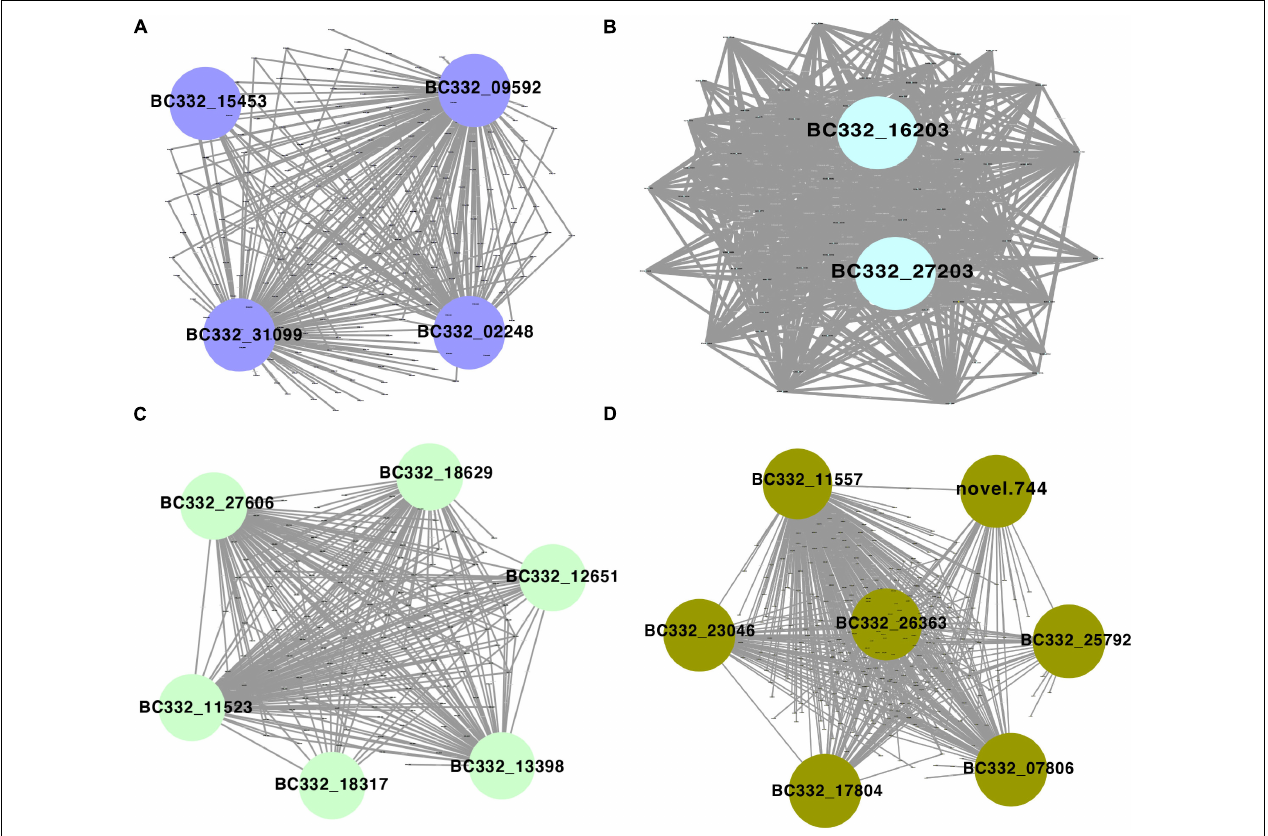
FIGURE 6 | Gene networks and hub genes involved in heterosis regulation during pepper development by WGCNA analysis. (A) Gene network of the purple module. (B) Gene network of the lightsheetblue1 module. (C) Gene network of the white module. (D) Gene network of the black module.